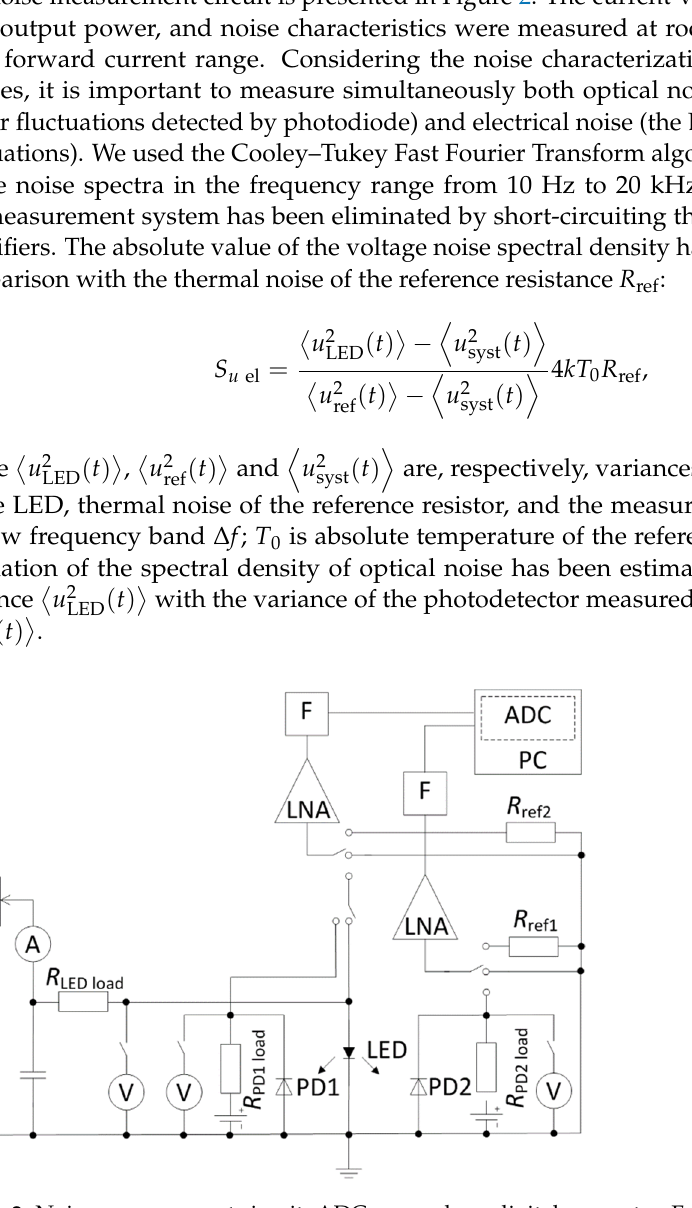
Figure 2. Noise measurement circuit: ADC, an analog−digital converter; F, a bandpass filter; LNA, a low-noise amplifier; PC, a personal computer; PD1 and PD2, photodetectors; R LED load , R PD1 load , R PD2 load , load resistances; R ref1 , R ref2 , reference resistors.